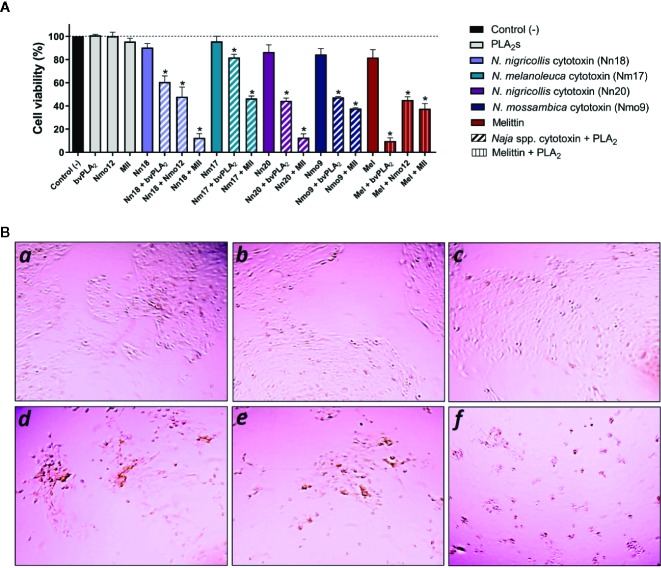
Synergistically enhanced lytic effects of combinations of cytotoxins and PLA2s from the same and different species. (A) Low lytic concentrations of cytotoxins (Nn18: 8 µg/ml, Nm17: 6 µg/ml, Nn20: 20 µg/ml, Nmo9: 1 µg/ml, and melittin: 5 µg/ml) were mixed with sublytic concentrations of PLA2s (Nmo12: 50 µg/ml, bvPLA2: 50 µg/ml, and MII: 12 µg/ml) and the combinations were added to human keratinocytes (N/TERT). Controls were performed with N/TERT cells not subjected to the toxins. Synergistically enhanced cytotoxicity was examined after 24 h of incubation by determination of adenosine triphosphate (ATP) levels through a luminescent cell viability assay. Experiments were performed in triplicates with two replicates for each combination, and results are expressed as mean ± SD. Data was analyzed by an analysis of variance (ANOVA) test followed by a Bonferroni post-test. (*p < 0.001 compared to the respective effect with the individual cytotoxin). (B) Representative morphological features of N/TERT cells captured by Evo XL imaging system using a 4× objective lens. (a-c) Standard N/TERT cell cultures forming islands of adherent and flattened keratinocytes, indicating viable cells: a: control; b: bvPLA2, and c: Nn18. (d-f) N/TERT cell cultures forming separated clusters of keratinocytes (fragmentation) and presenting several rounded cells, indicating cell damage and lysis: d: Nn18 + bvPLA2; e: Nn18 + Nmo12, and f: Nn18 + MII. Similar patterns were seen for other toxins.